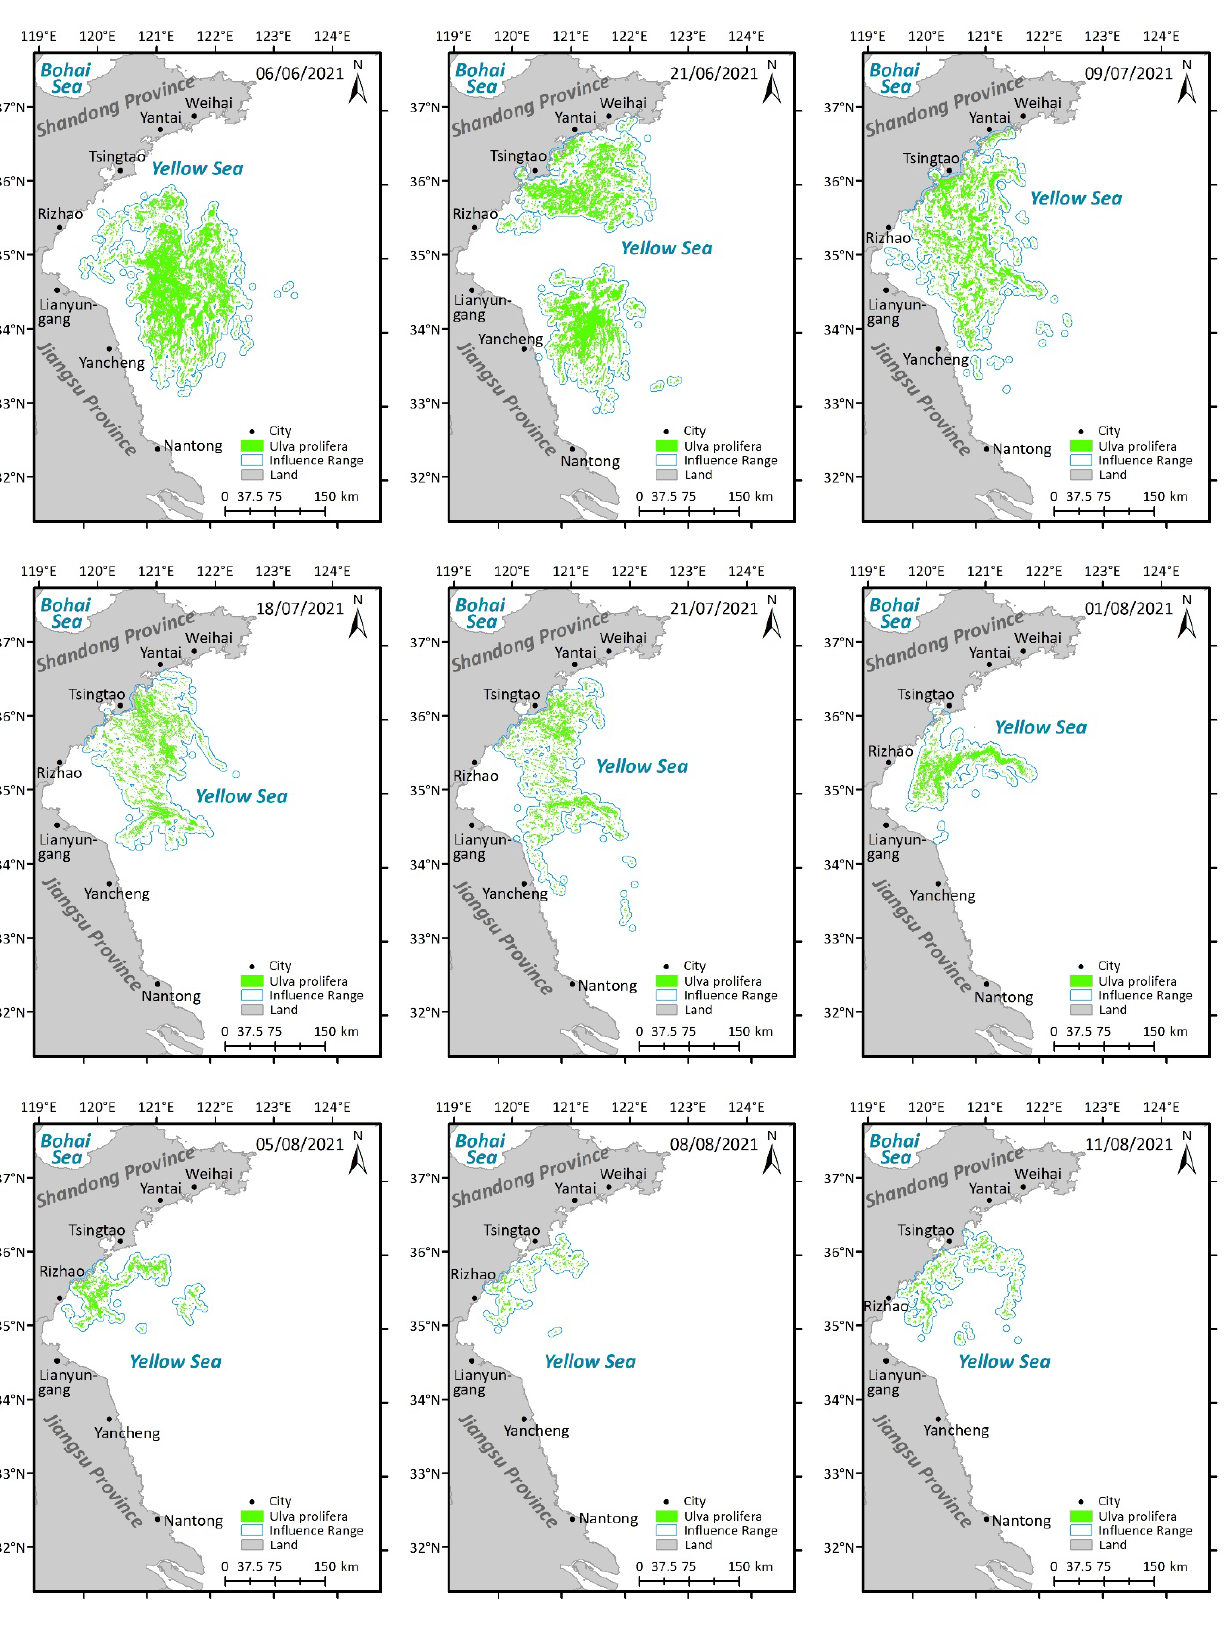
Figure 7 . Cont. Figure 7. Cont